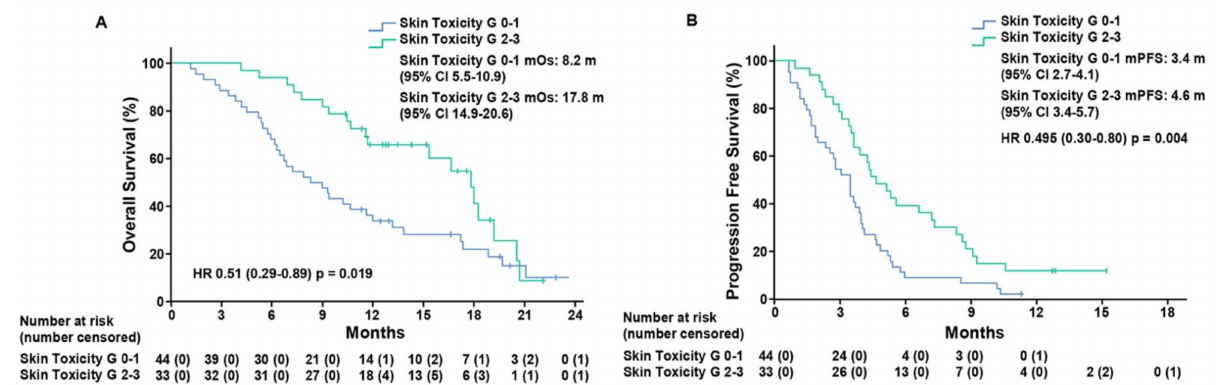
Figure 1. Kaplan–Meier estimates of overall survival ( A ) and progression-free survival ( B ) in the intention-to-treat popula- tion according to skin toxicity grade 0–1 and grade 2–3. Grade, G; median overall survival, mOS; median progression-free survival, mPFS; months,